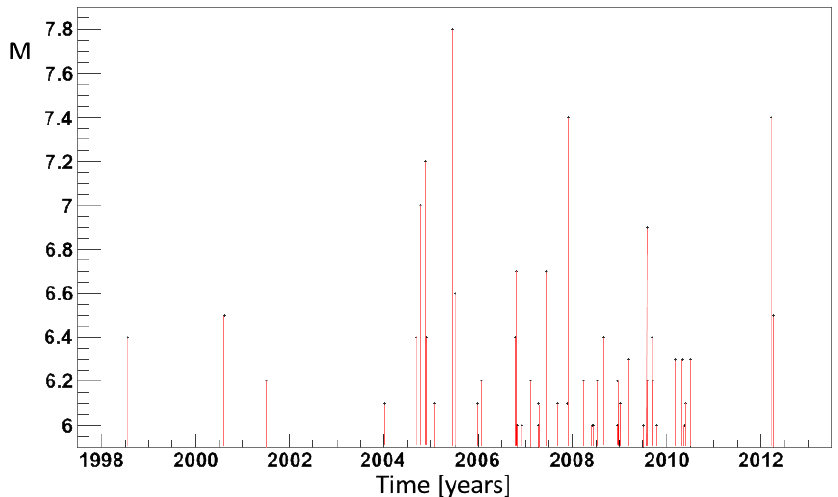
Figure 6. The EQ magnitudes reported with respect to EQ times contributed to the correlations in Figure 2.